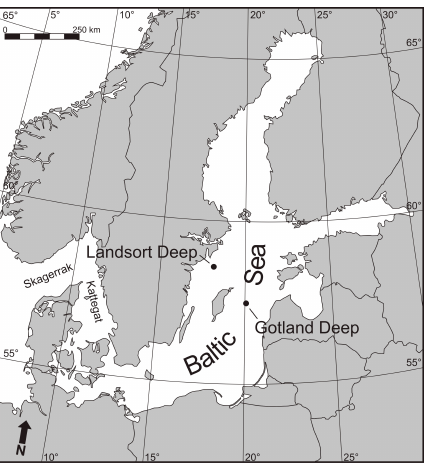
Figure 1. Map showing the sampling locations in the central Baltic